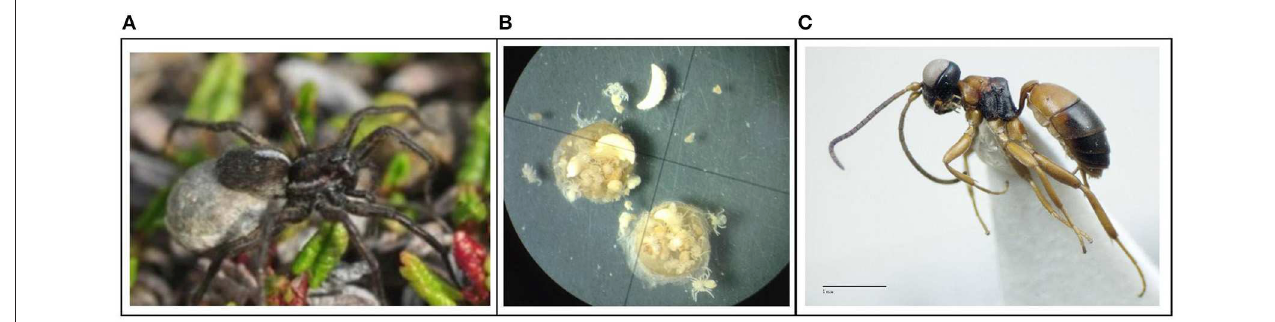
FIGURE 1 | Egg sac parasitism of wolf spiders by parasitoid wasps is common in arctic and temperate ecosystems, including in SW Greenland, where populations of P. glacialis are parasitized by the wasp G. micrurus . (A) Female P. glacialis with egg sac; (B) Egg sac contents with a mix of wolf spider eggs and parasitoid larvae;